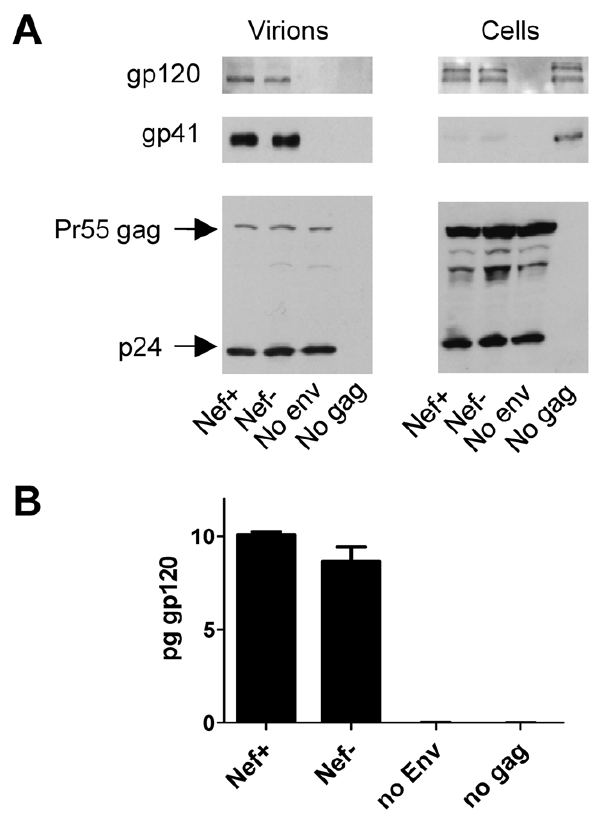
Figure 2. Nef does not alter the efficiency of Env incorporation into virus particles. A. Western blotting of pelleted wild-type and Nef-defective HIV-1 NL4-3 virus particles and producer cells extracts (Jurkat), showing abundance of gp120, gp41 and Gag. A sample expressing an env -defective HIV-1 NL4-3 (no Env) and a sample expressing a gag -defective provirus construct (no Gag) were used to control the assay specificity. B. Quantitative gp120 Elisa of the same samples shown in A. Results show average and standard deviation of triplicate determinations.